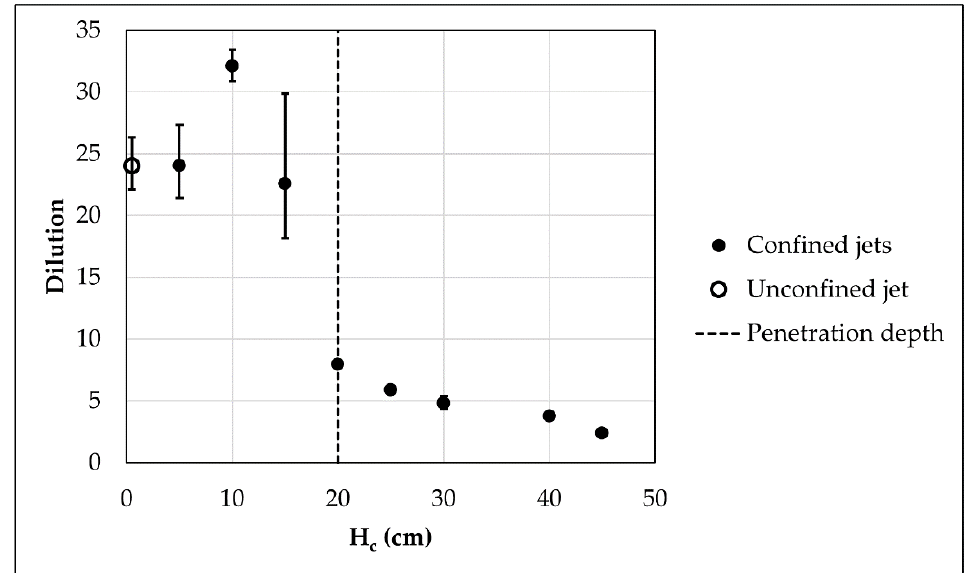
Figure 4. Dilution measurements for confined plunging jet experiments with H = 50 cm, L j = 60 cm, D c = 4.4 cm and ∆s = 10 psu. (Dilution of an unconfined plunging jet with H = 50 cm, L j = 60 cm and ∆s = 10 psu is plotted at H c ≈ 0.)